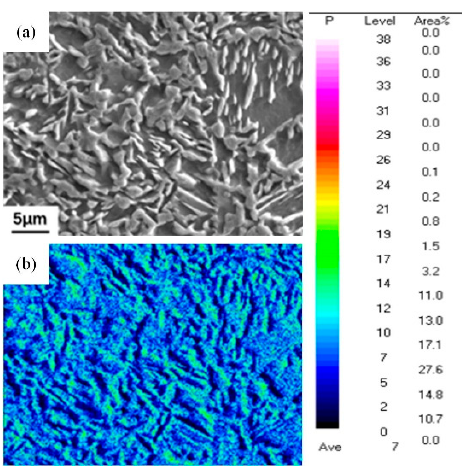
Figure 8. EPMA analysis of the segregation of phosphorus. ( a ) Microstruture; ( b ) segregation of phosphorus.